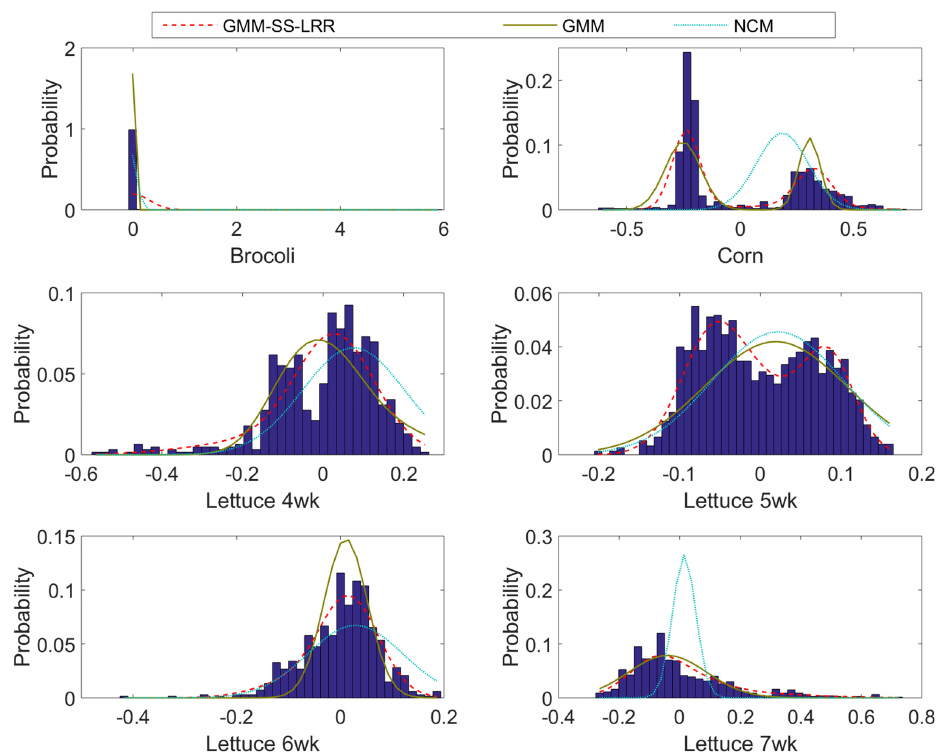
Figure 13. Histograms of pure pixels for the Salinas-A dataset and the estimated distribution from GMM-SS-LRR, GMM and NCM when projected to one